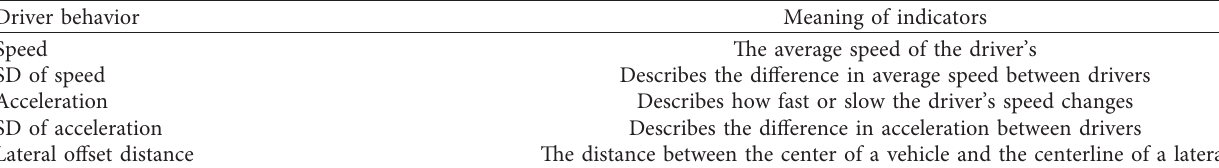
Table 1: Indicators of driver behavior.